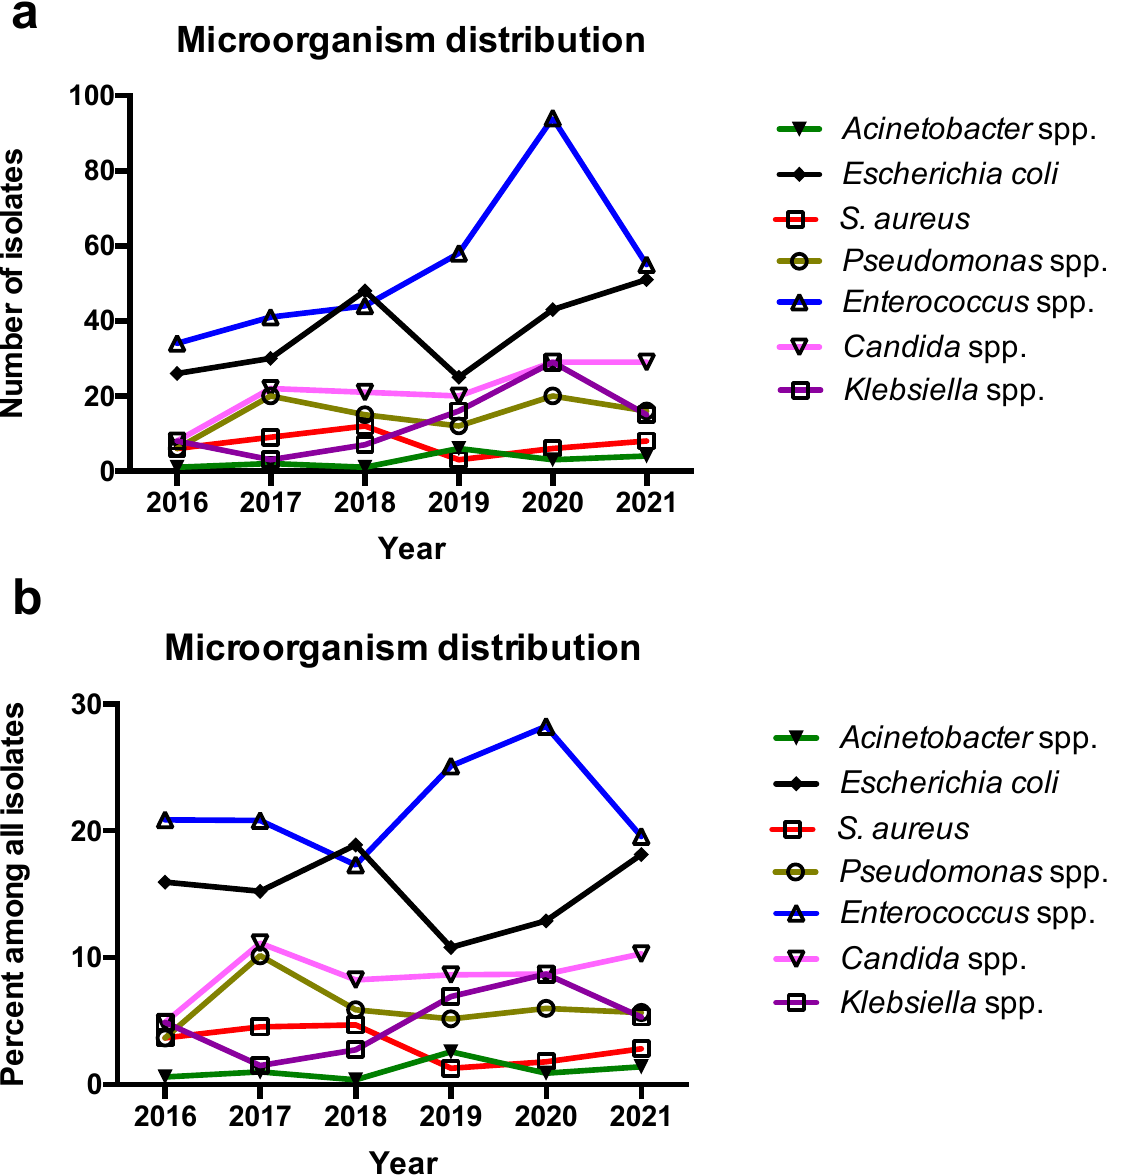
Figure 1. Number and rate of isolated microorganisms from patients’ samples in regard to the year. The number of microorganisms is shown in ( a ), while, the percent of microorganisms among all isolated pathogens is shown in ( b ).